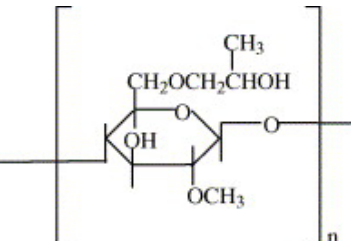
Figure 3. Structure of hydroxypropyl methylcellulose (adapted from Wang et al .